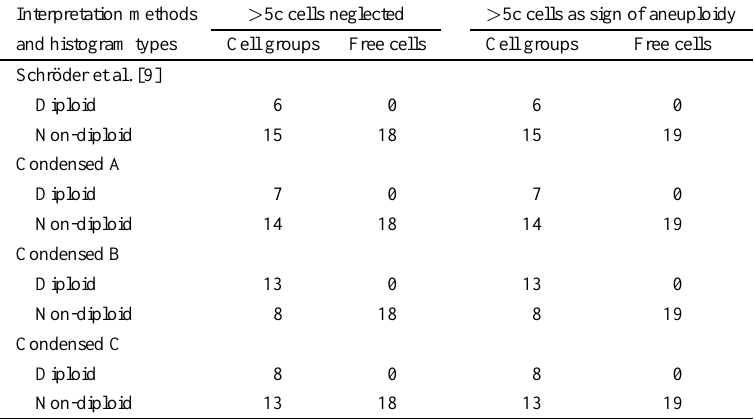
Diploid histograms and histograms of non-diploid character, including peridiploid, tetraploid, peritetraploid, aneuploid and multiploid patterns after two sampling methods, and two differ- ent ways of interpretation of the > 5c